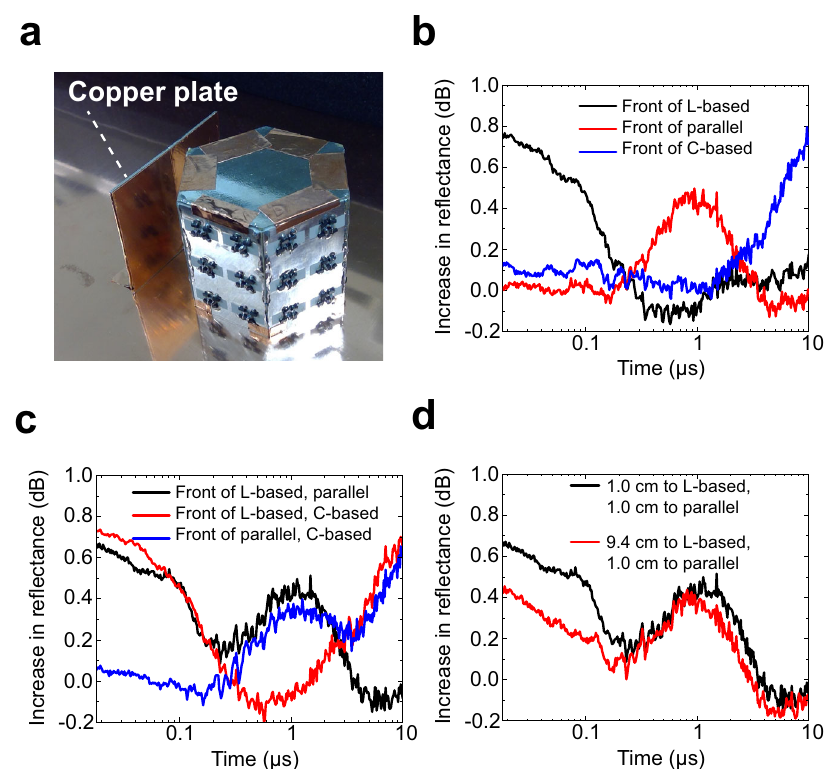
Fig. 4 | Passive variable sensor to detect the location of scattering objects. a Antenna system used in Fig. 3 in close proximity to a copper plate (70mm wide and 51mm tall). The distance between the copper plate and the closest waveform- selectivemetasurfacepanelswassetto1.0cmasadefaultvalue.Thefrequencyand power were 3.85GHz and 30dBm, respectively. b Measurement results when the copper plate was deployed in front of either the C-based, L-based, or parallel